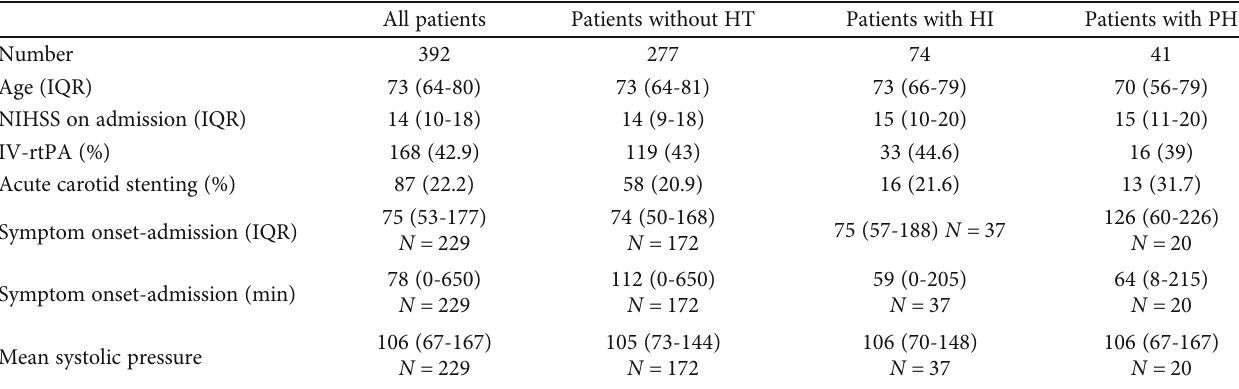
Table 1: Patient characteristics.